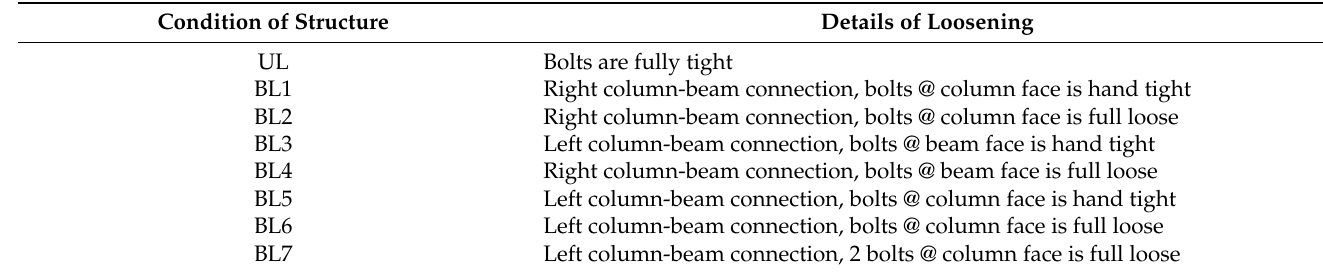
Figure 4. Bolt loosening cases ( a ) BL1, ( b ) BL2, ( c ) BL3, ( d ) BL4, ( e ) BL5 and ( f ) BL6. Table 2. Experimental study case